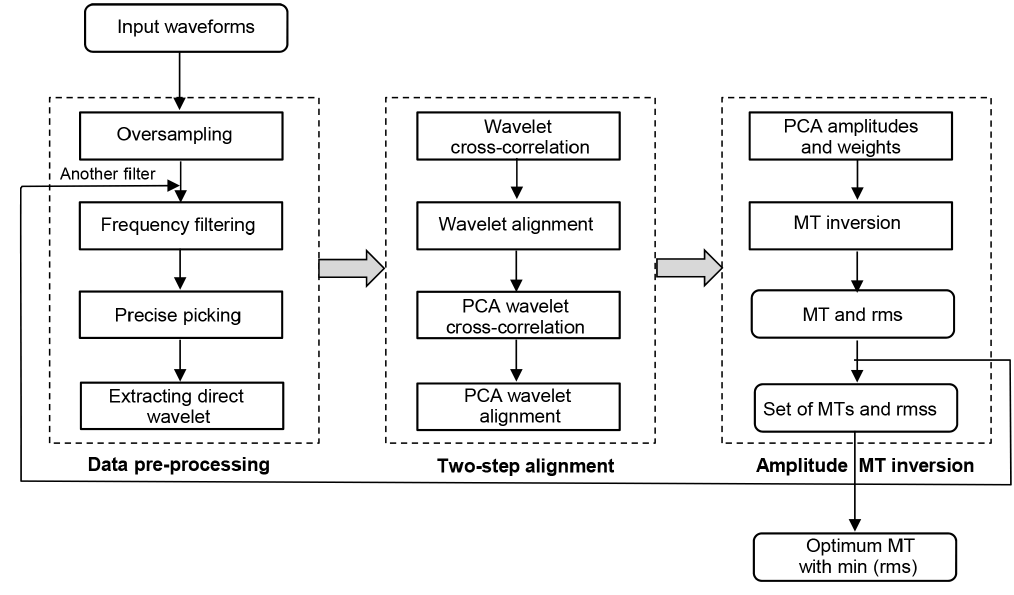
Figure 5. Flowchart of the PCA moment tensor inversion.